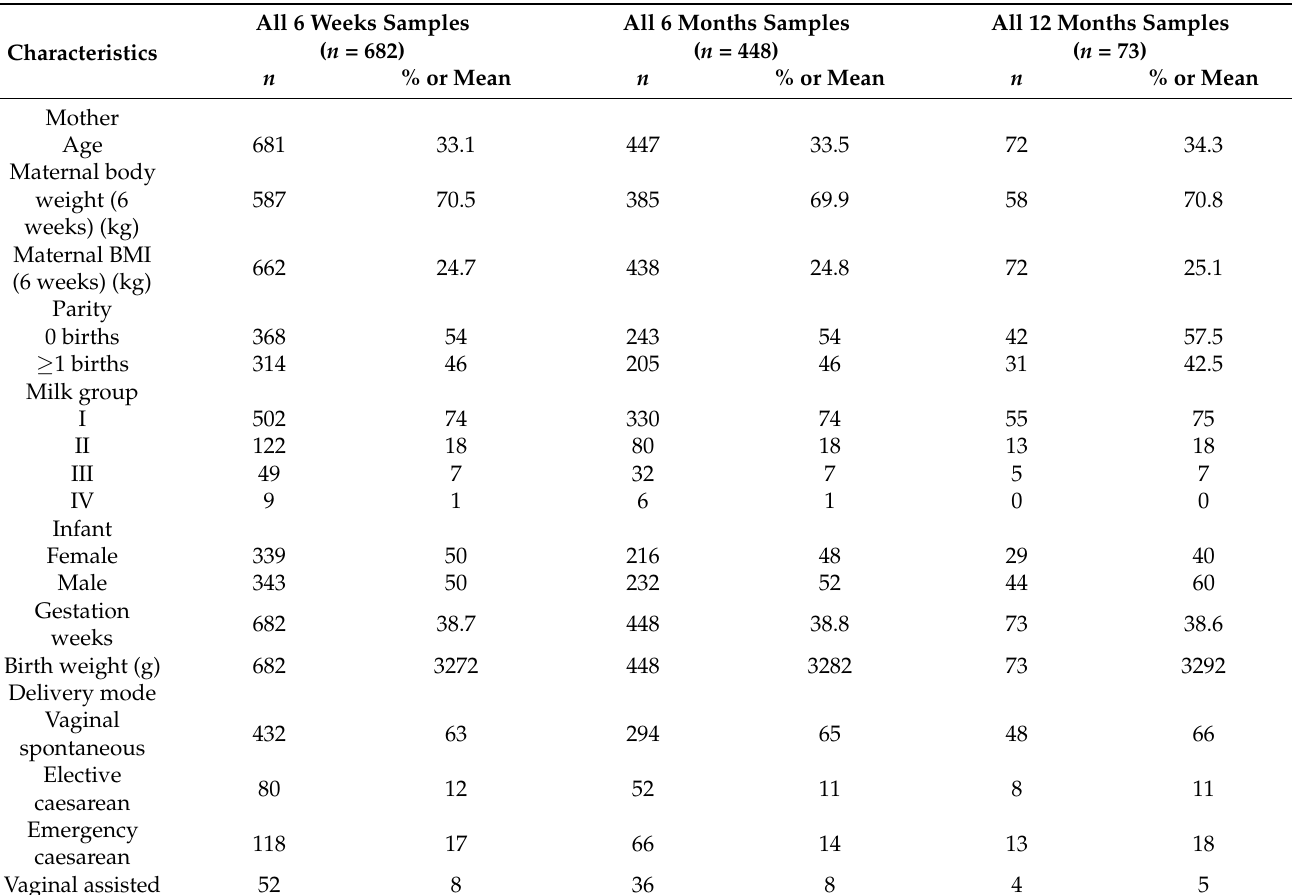
Table 1. Characteristics of lactating mothers whose human milk samples were available for human milk oligosaccharide (HMO) analysis in the Ulm SPATZ Health